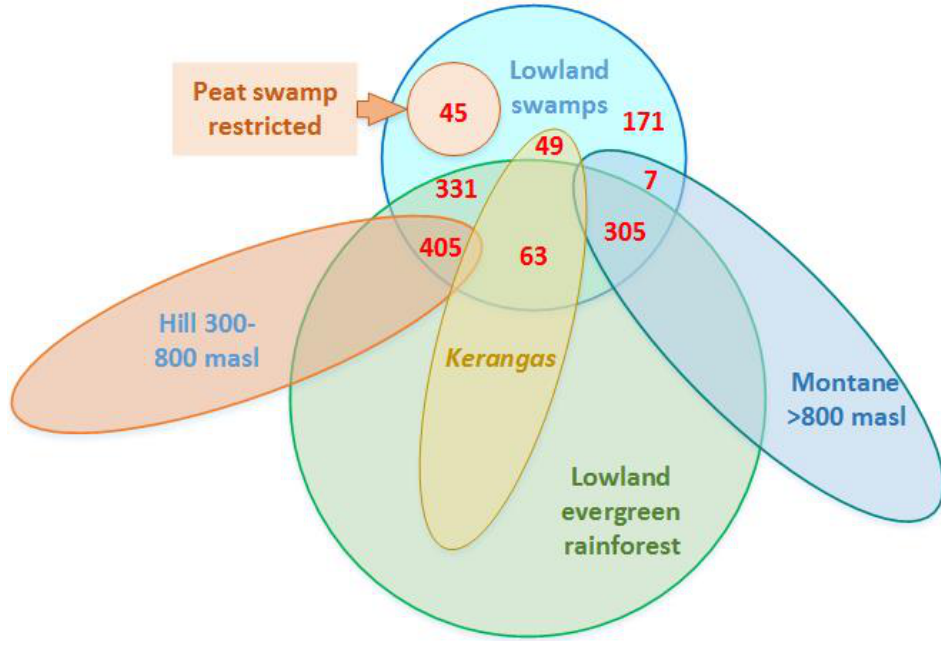
Figure 1: Plant species shared between lowland swamps and other habitats in Southeast